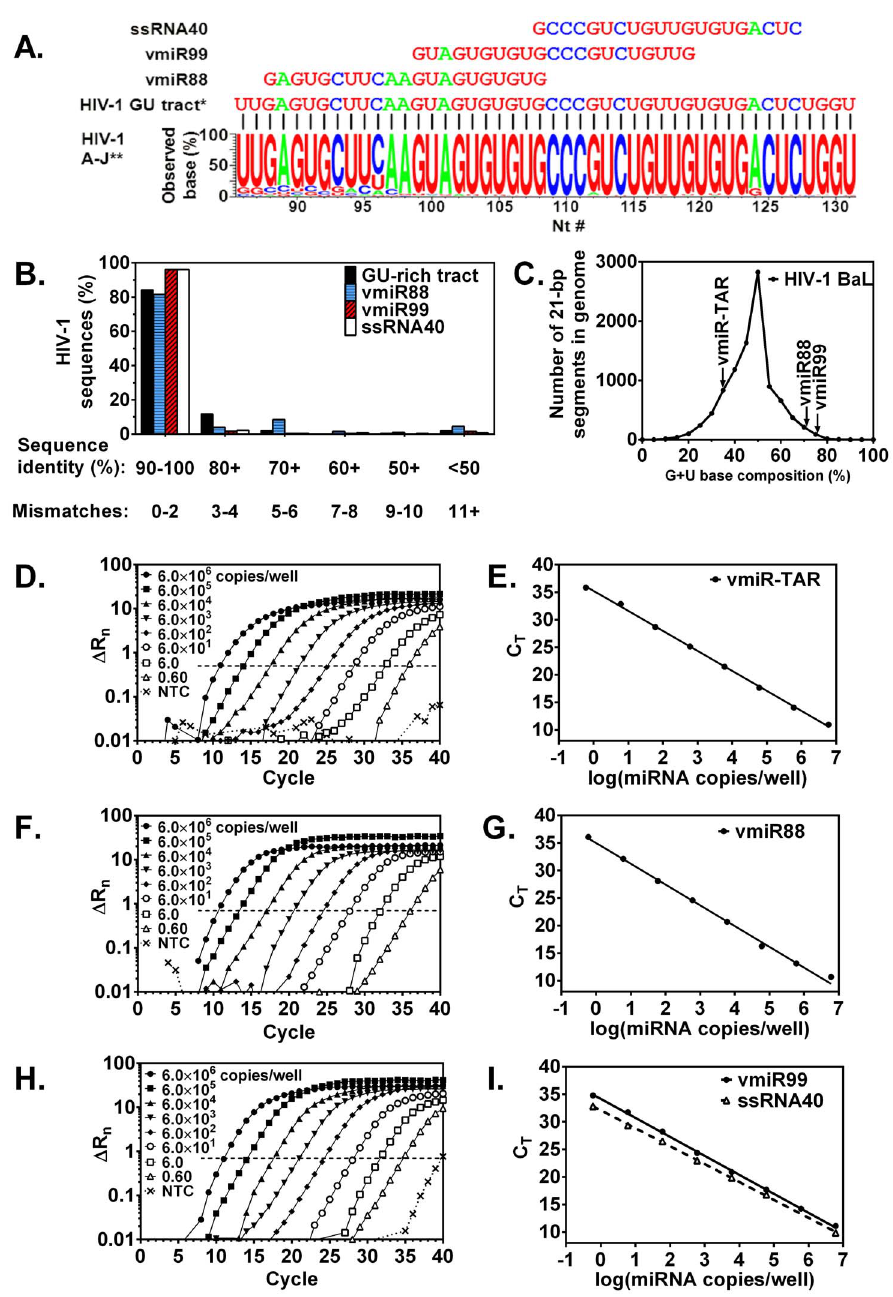
Figure 2. Sequence alignment of HIV vmiRs with consensus genomic sequence from HIV-1 subtypes and absolute quantitation of miRNAs by Real Time RT-PCR. A : Alignment of vmiR sequences of GU-rich tract is consistent with consensus genomic sequence from HIV-1 subtypes A-J, 533 isolates. B : VmiR99 is 90–100% identical to 96% of HIV-1 sequences. Sequences within the GU tract, vmiR88, vmiR99 and ssRNA40 were aligned with 196, 201, 254 and 272 genome sequences, respectively. C : Genomic RNA of HIV-1 BaL strain was scanned for every 21-bp RNA segment and the distribution of base compositions (46.5 6 11.8% G + U) is shown. VmiR-TAR is GU-poor (35%). VmiR88 and vmiR99 are GU-rich (71% and 76% G + U, respectively). Absolute quantitation of miRNAs was determined by Real Time RT-PCR. After first strand cDNA synthesis, amplification ( D, F, H ) and absolute quantitation ( E, G, I ) of vmiR-TAR ( D–E ) vmiR88 ( F–G ), vmiR99 ( H–I ) and RNA40 (I) was standardized using synthetic miR oligonucleotides in the miRCURY LNA Universal RT microRNA PCR method (Exiqon) on an ABI 7900HT FAST Real Time PCR system. D R n is the change in normalized reporter fluorescence intensity. C T is the threshold cycle in which the amplification curve crosses the dashed horizontal line. Data depict a representative experiment done in duplicate.